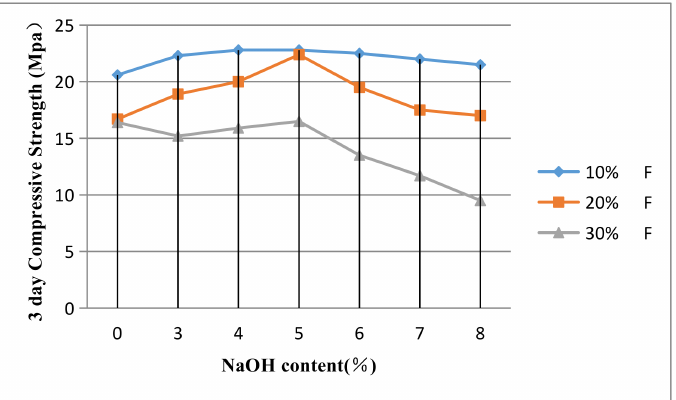
Figure 1. NaOH content–compressive strength curves at 3 days.